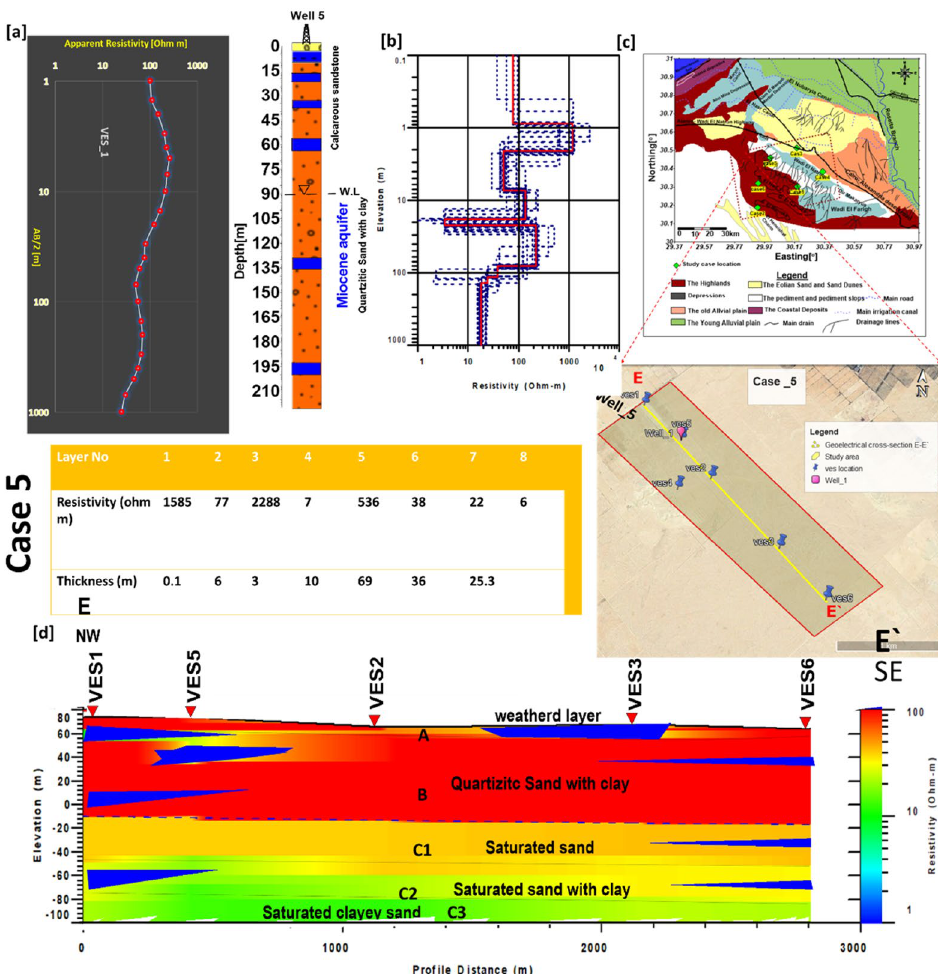
Figure 9. ( a ) VES5 as example for case 5 with Well 5, ( b ) inverted model with cumulative models, ( c ) the location of E–E ′ cross section in the study area, ( d ) inverted resistivity cross section E–E ′ in the fives study